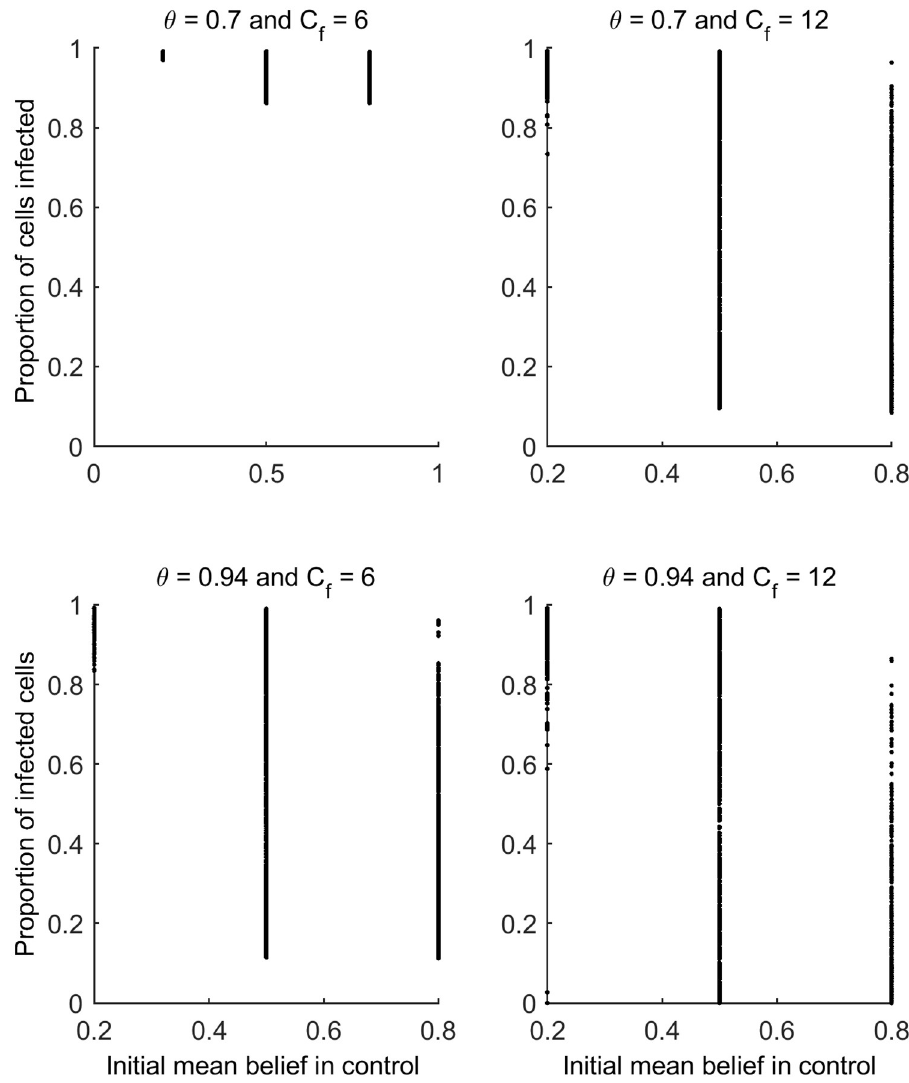
Fig 6. The results of the simulations. The proportion of cells (1-ha areas) infected at the end of the simulation is plotted against the initial belief in the control method for each combination of spray efficacy ( θ ) and spray frequency ( C f ). On all simulations the frequency information was disseminated was set to zero ( E f = 0). All other parameters values were varied as described in Table 2 resulting in the ranges of outcomes observed for each combination of θ and C f